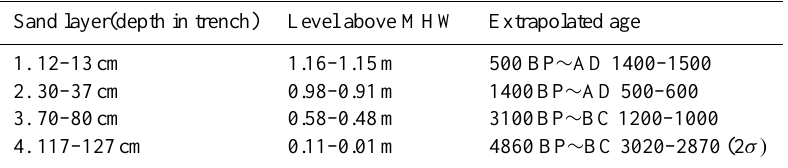
Table 1. Extrapolated age for the sand layers at Kirra. Extrapolation is based on the radiocarbon date of a shell from sand layer 4 and assuming a constant sedimentation rate of 2.6cm (100yr) − 1